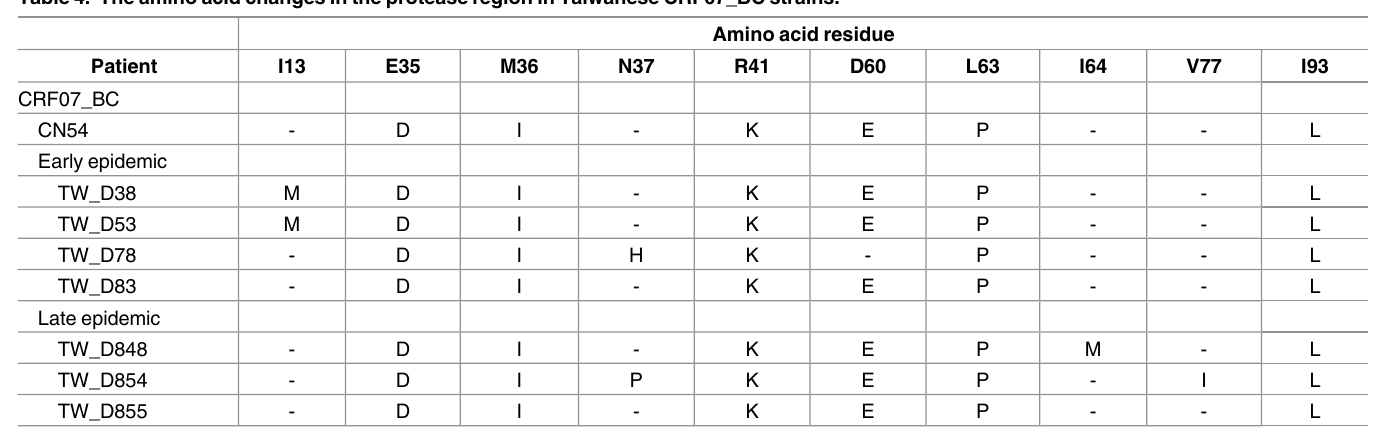
Table 4. The amino acid changes in the protease region in Taiwanese CRF07_BC strains.